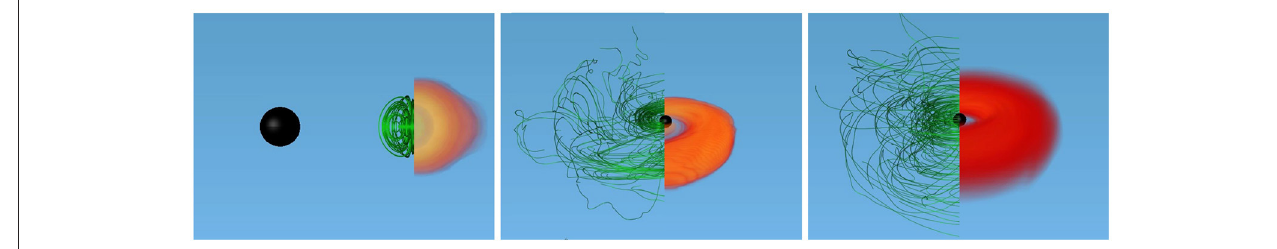
FIGURE 1 | The NS magnetic field lines (green) and rest-mass density ρ 0 (reddish) normalized to the initial NS maximum value ρ 0 = 8.92 × 10 14 (1.4 M ⊙ / M NS ) 2 g / cm 3 , at selected times for a BHNS with mass ratio q = 3. The initial BH spin is a BH / M BH = 0.75 and the NS is an irrotational Ŵ = 2 polytrope. Here the BH apparent horizon is shown as a black sphere. Following merger, the field lines are wound into an almost purely toroidal configuration (adapted from Etienne et al., 2012b).